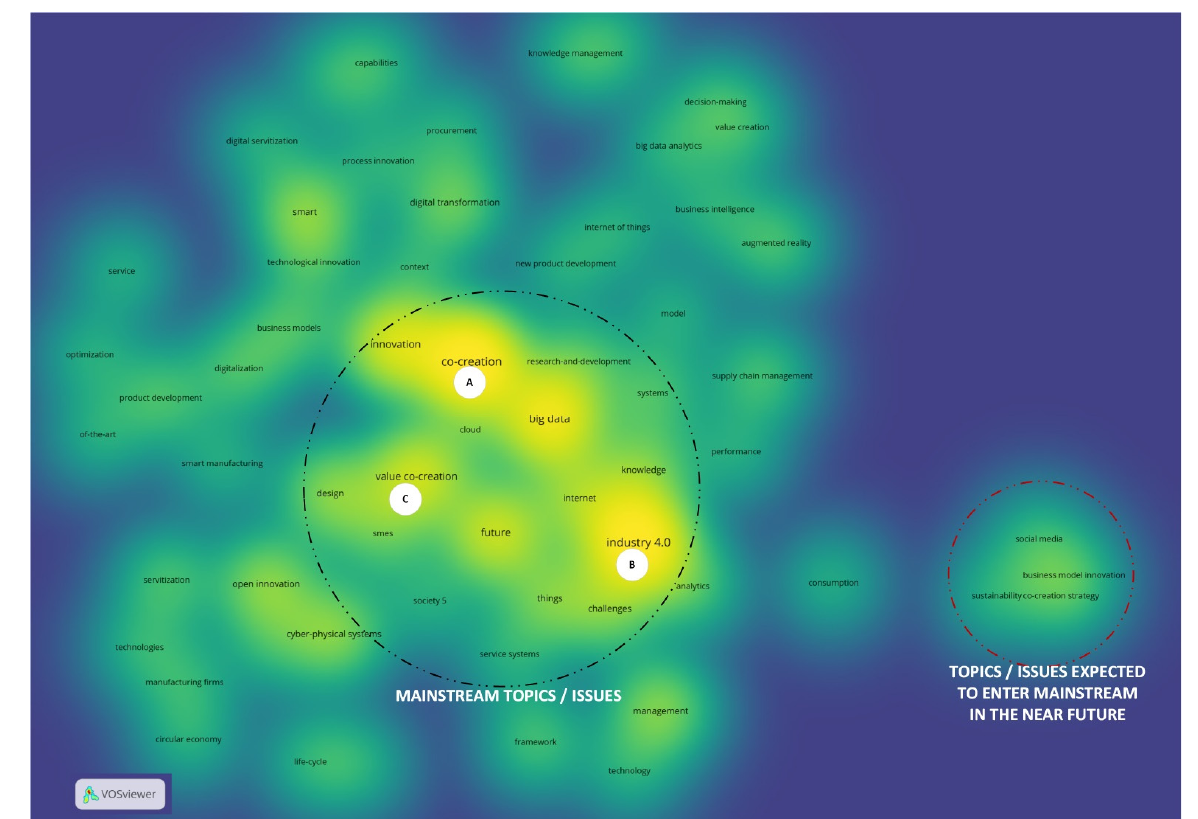
Figure 2. “Industry 4.0” and “co-creation” keyword co-occurrence in WoS CC indexed articles— Network Visualization and Density Visualization maps. ( Upper ) RGB and high-resolution version of the map available at: https://tiny.pl/9k4ms (accessed on 31 March 2022). ( Below ) RGB and high-resolution version of the map available at: https://tiny.pl/9k4mv (accessed on 31 March 2022). Source: Own elaboration.